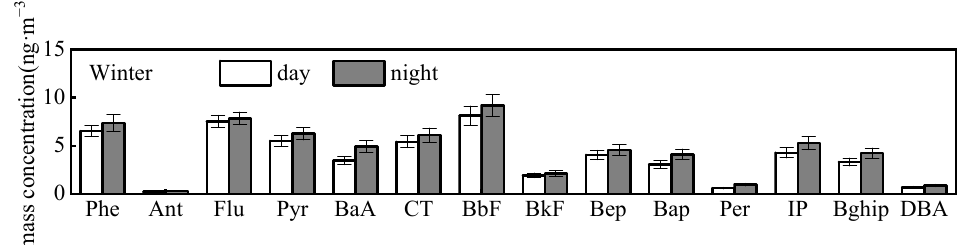
Figure 3. Daily variations of individual PAH mass concentrations in winter (error bars represent min.–max. concentrations).